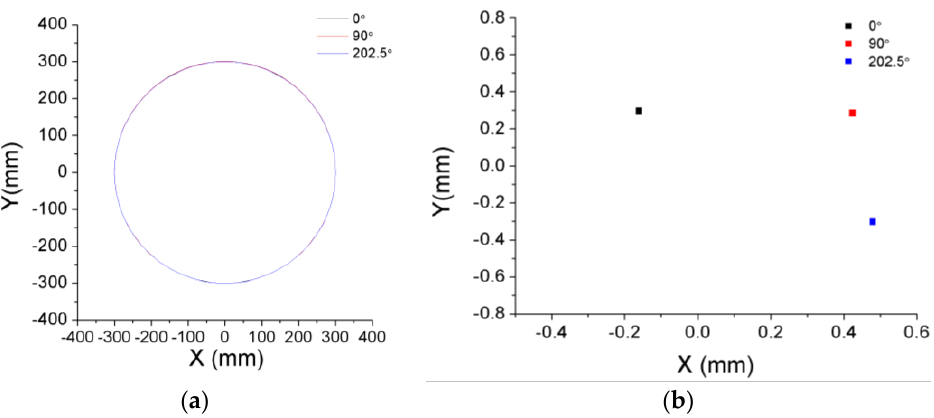
Figure 9. Disk circumferences calculated from the TC measurements of the three OFSs at three different turning positions: 0 ° , 90 ° , 202.5 ° ( a ); Positions of the centers of the circumferences ( b ).